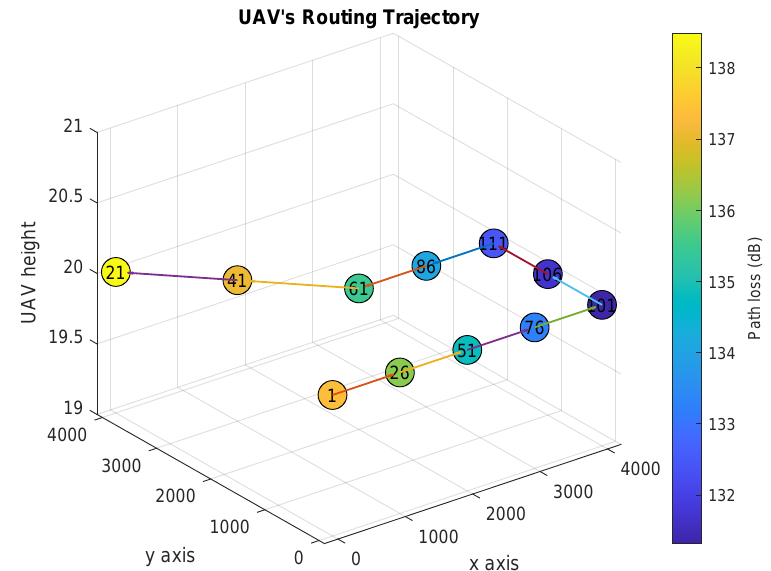
Figure 7. UAV’s trajectory design over the path loss map using Algorithm 1 (Scenario 1).